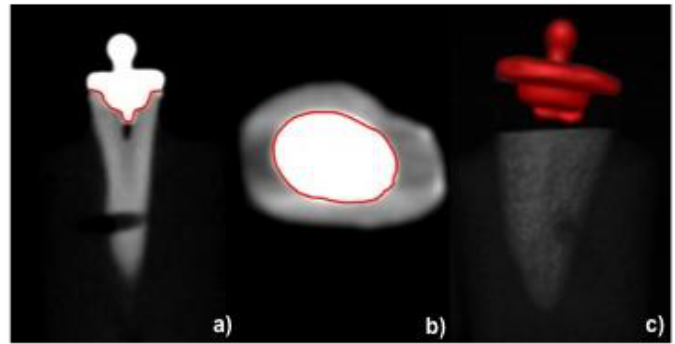
Figure 2. ( a–c ) Digital volume tomography (DVT) image of restored tooth on ( a ) sagittal, ( b ) coronal section, and ( c ) the perspective view of 3D reconstructed surface. Contours of cemented surface, highlighted in red, are determined for each DVT slice and surface reconstructed to calculate the adhesive area.